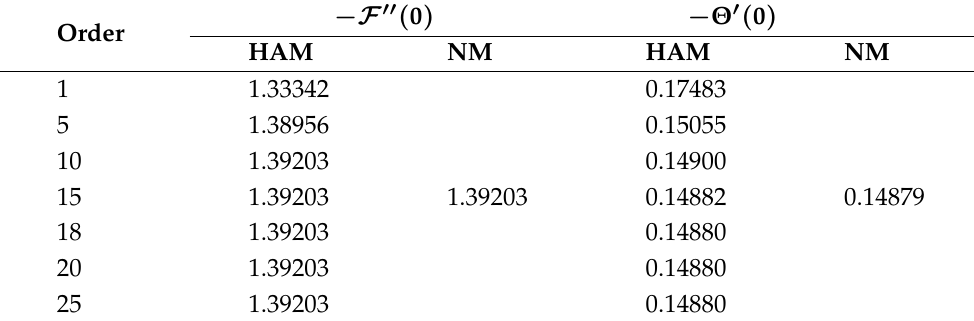
Table 2. HAM order and numerical value of SWCNTs.